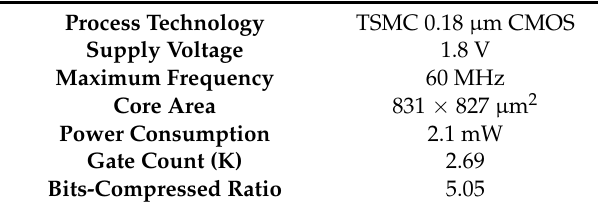
Table 2. Hardware characteristics of the proposed